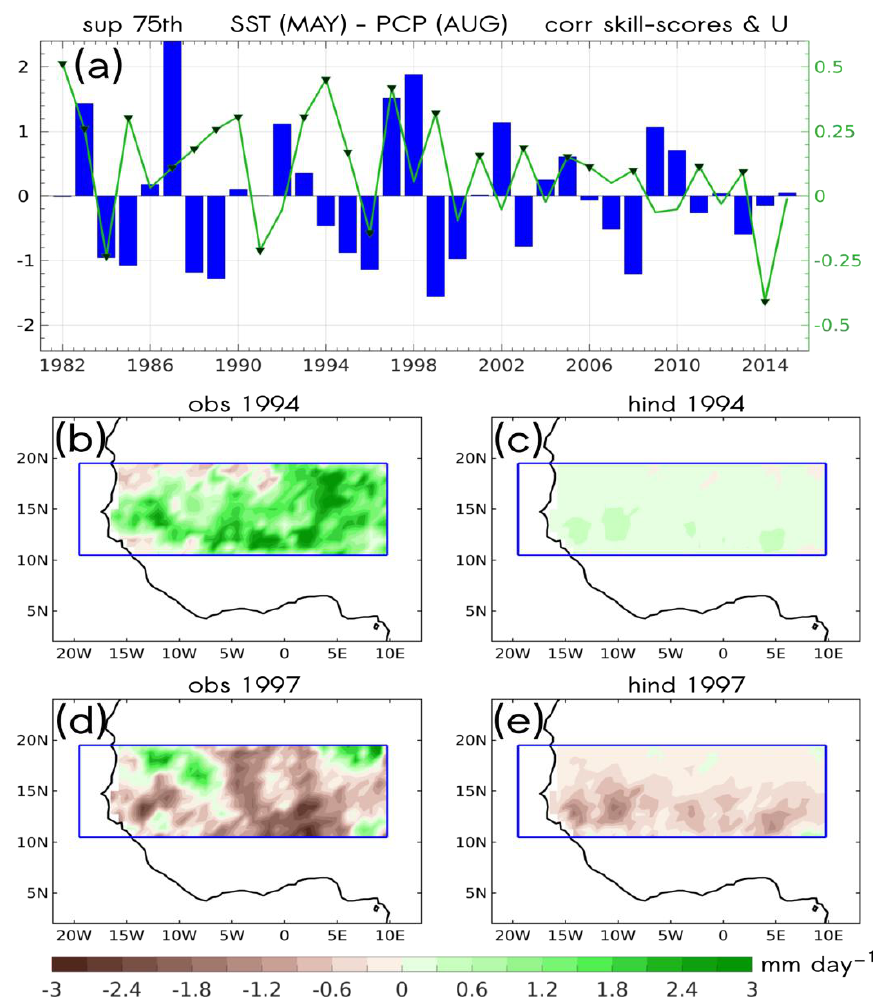
Figure 8. As in Figure 7 but for the leading MCA mode between SSTA in the Niño 3.4 region (170°– 120° W; 6° S–6° N) in MAY (lag 3), and the anomalous Sahel (20° W–20° E; 10°–20° N) rainfall above the 75th percentile in AUG ( a ). The case studies correspond to ( b , c ) 1994 and ( d , e ) 1997.